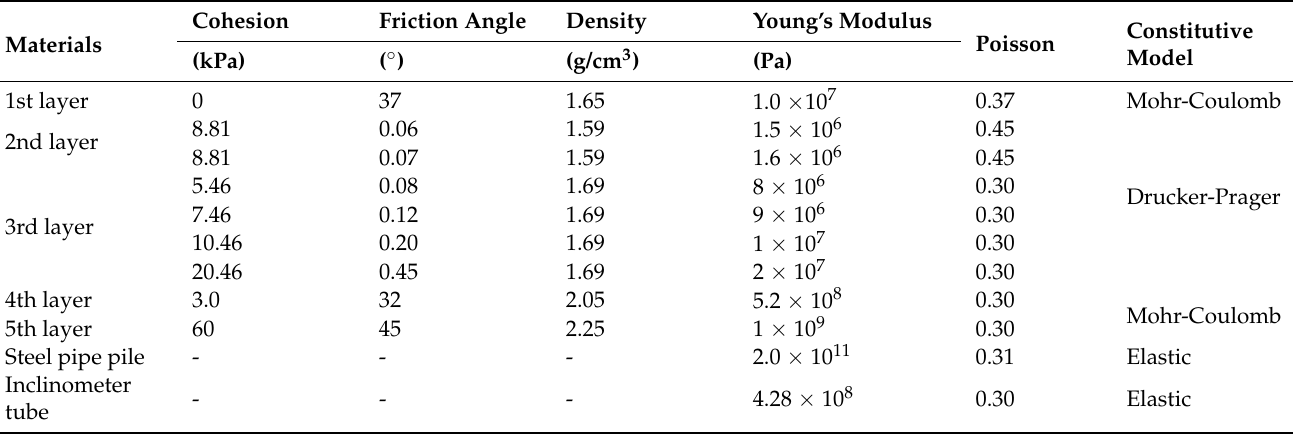
Table 1. Material